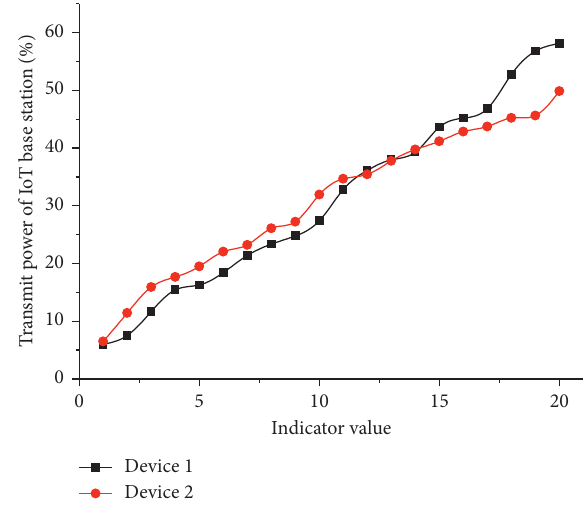
Figure 5: Comparison of transmission power integration of In- ternet of Things base